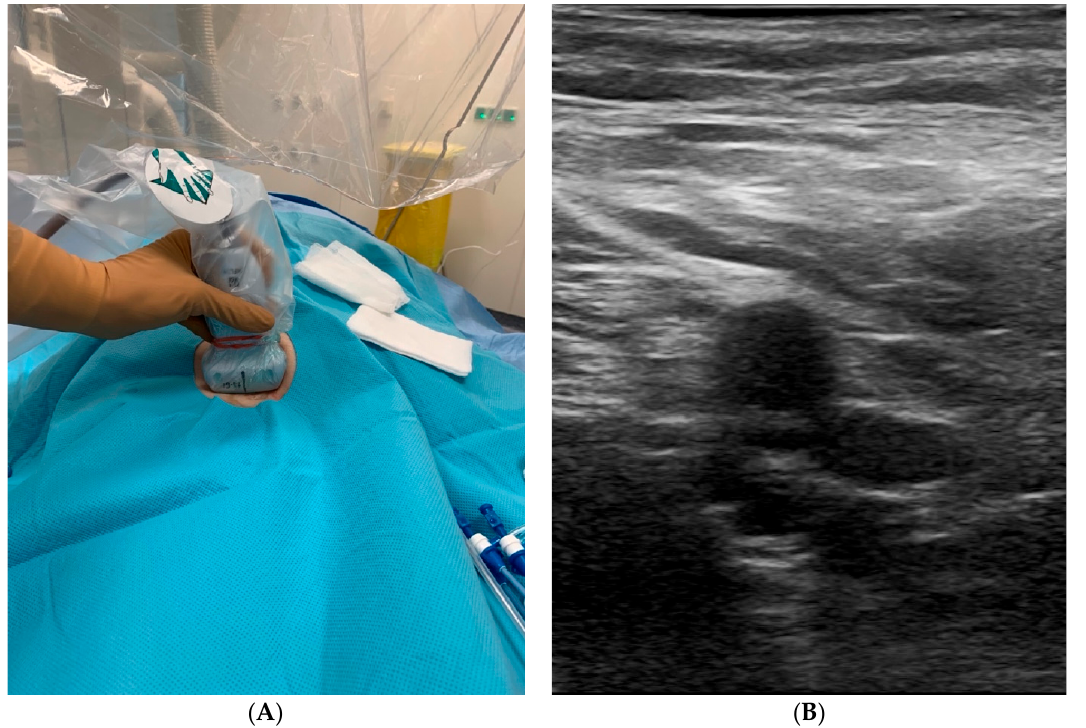
Figure 1. UGVP in the right groin. ( A ) The operator holds the probe while puncturing with the other hand. ( B ) The optimal site for puncture with the vein and artery visualized side-by-side (A: artery; V: